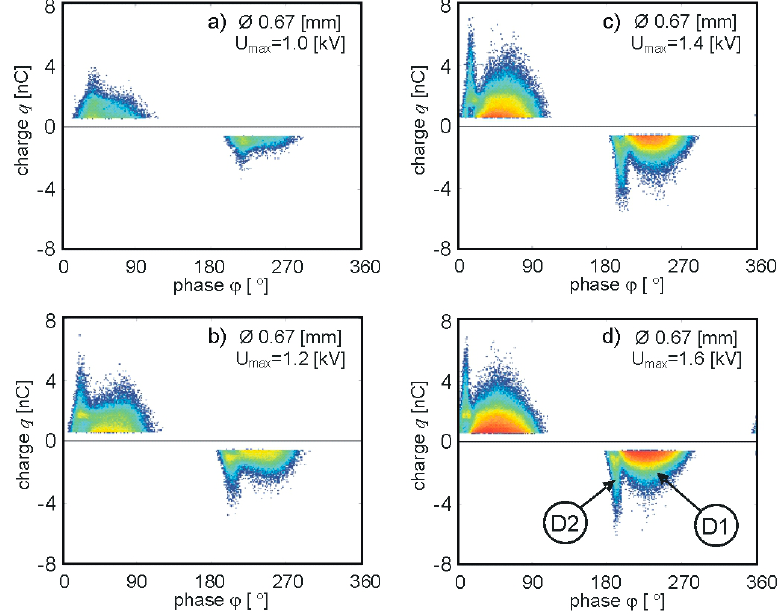
Figure 21. The PRPD patterns acquired for TP1 sample at four test voltage values: ( a ) U max = 1.0 kV; ( b ) U max = 1.2 kV; ( c ) U max = 1.4 kV; ( d ) U max = 1.6 kV.